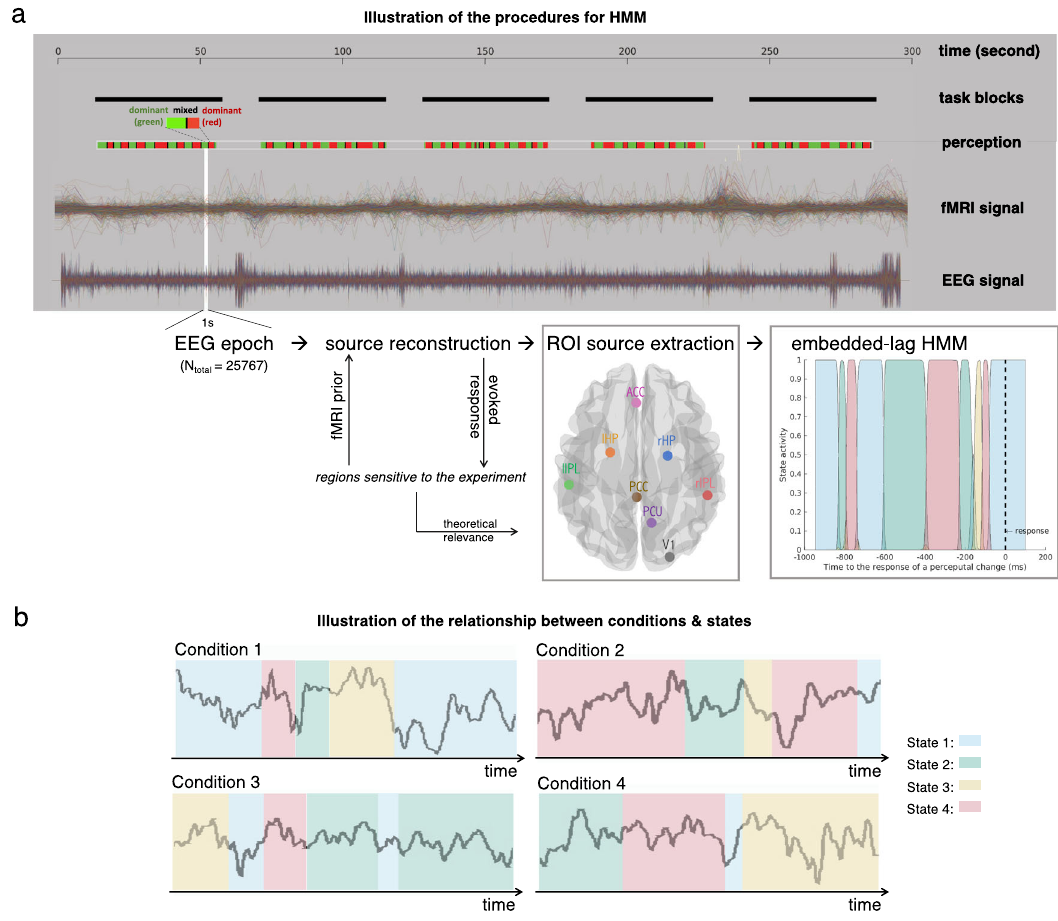
Fig. 4 | Schematic illustration of the procedures for HMM. a Illustration of the HMManalysispipeline.Theone-secondEEGepochs/trialsweretakenrightbeforea responseofeveryperceptualchange( “ dominant ” inredorgreen, “ mixed ” inblack). Toensureexperimentalsensitivity,weselectourregionsofinterest(ROIs)fromthe signi fi cant results of the source-level evoked response in our previous analyses. Also because of our theoretical interest, we further constrained our selection of ROIsbychoosingonlytheV1andDMNregions(amongallthesigni fi cantvoxels)to constructthe HMM. In the last subplot we presentedanexample of how the states change across time in a random trial. The motivation and procedures for selecting